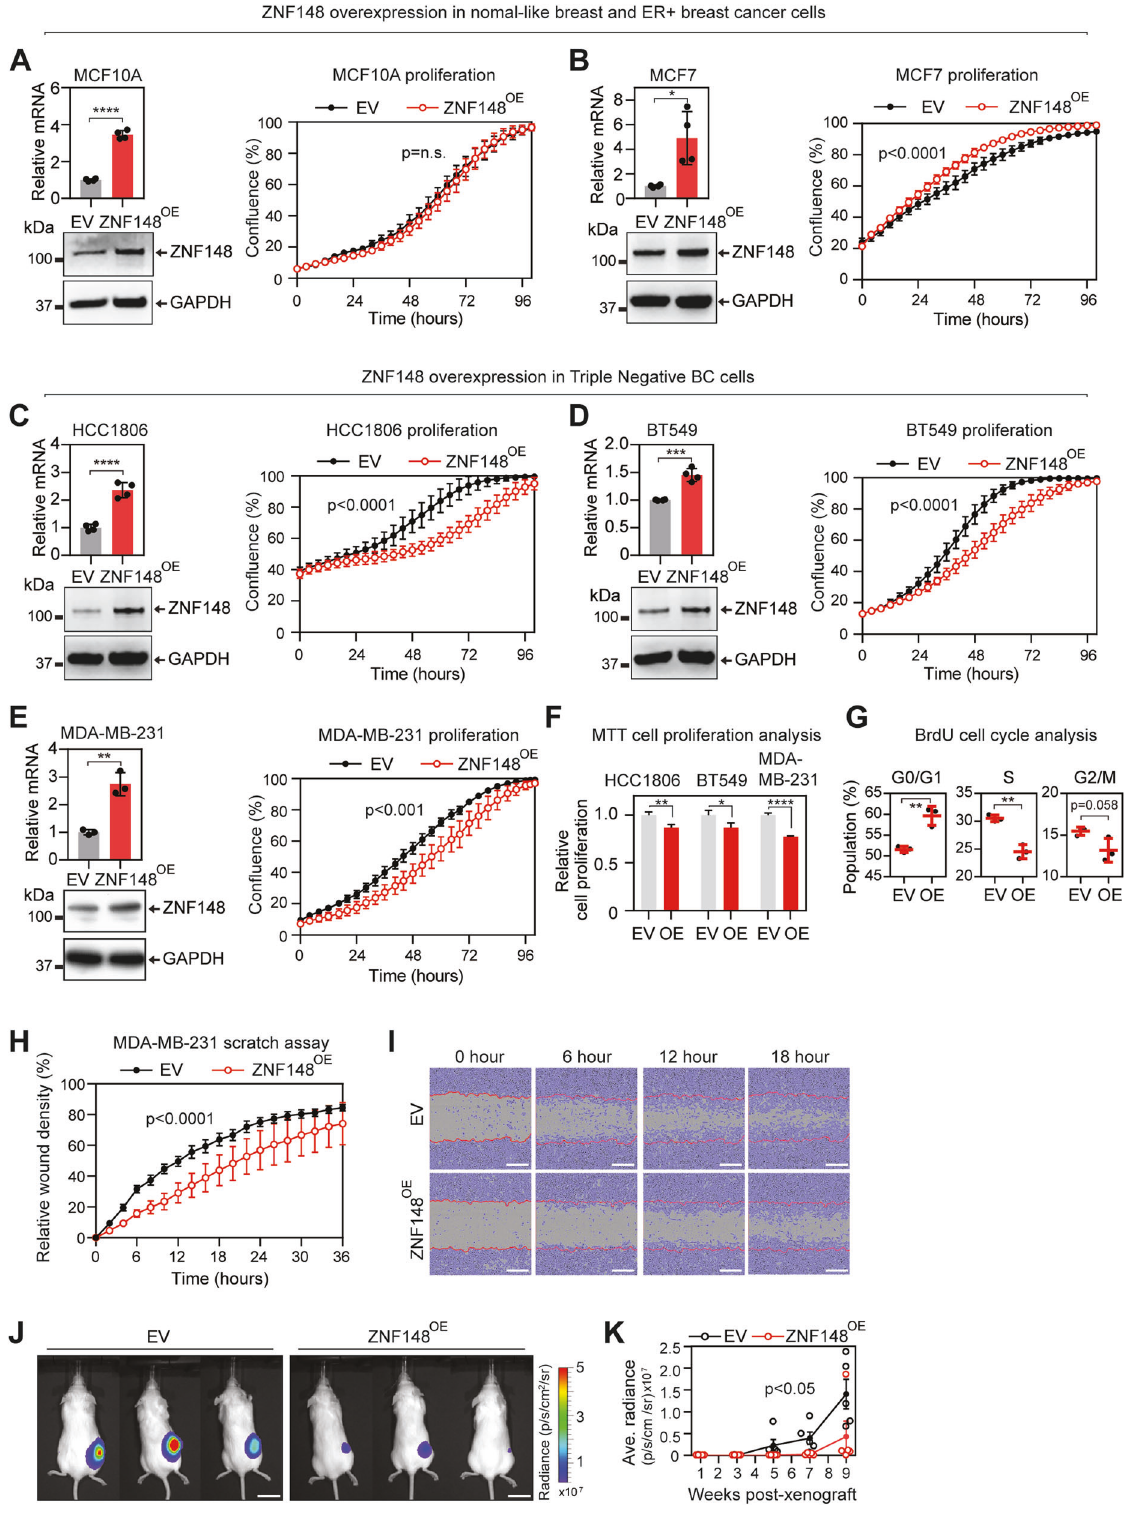
ZNF148 suppresses breast cancer cell growth and migration To determine the functional signi fi cance of ZNF148 in breast cancer, we used lentivirus to stably express ectopic ZNF148 cDNA into ER + breast cancer (MCF7), TNBC (MDA-MB-231, BT549, and HCC1806), and normal-like breast (MCF10A) cell lines. RT-qPCR